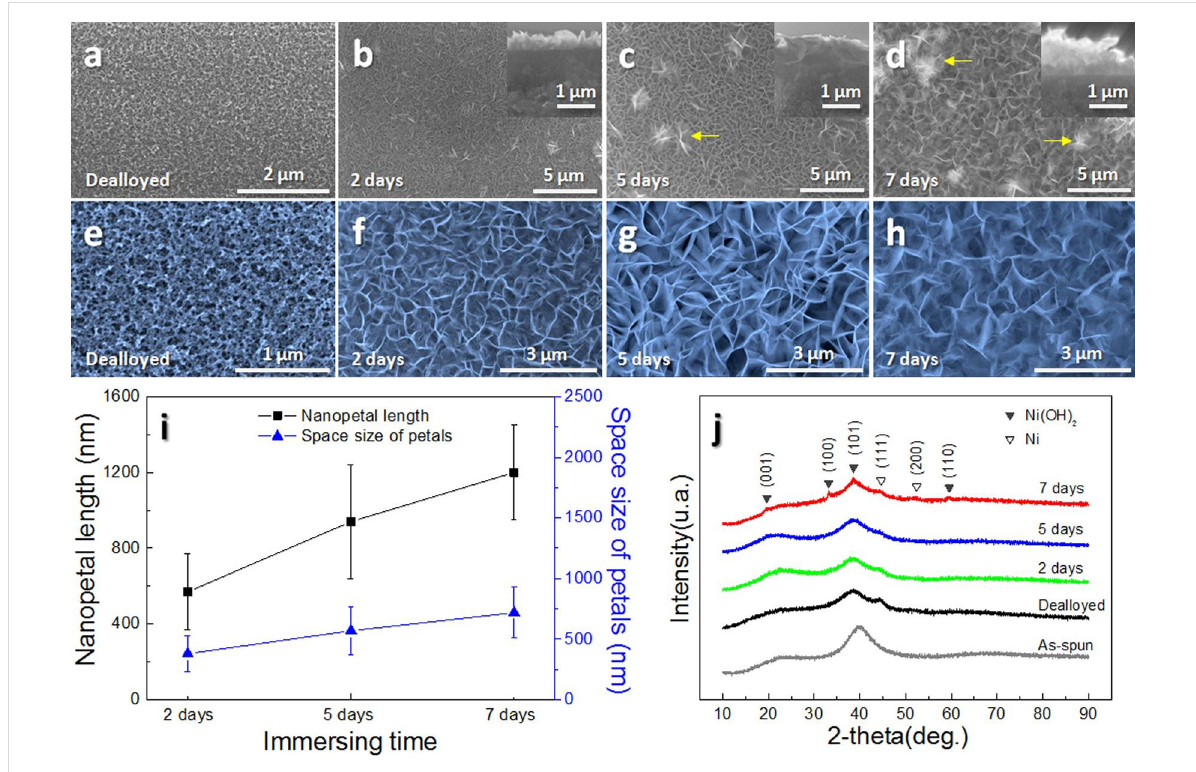
Figure 2: Low- and high-magnification SEM images of (a, e) the as-dealloyed ribbon, (b, f) Ni(OH) 2 /Ni-NF/MG-2, (c, g) Ni(OH) 2 /Ni-NF/MG-5, and (d, h) Ni(OH) 2 /Ni-NF/MG-7; the insets are the corresponding cross-sectional views. (i) Nanopetals length and space size of petals as functions of the immersion time. (j) XRD patterns of the as-spun, as-dealloyed and Ni(OH) 2 /Ni-NF/MG